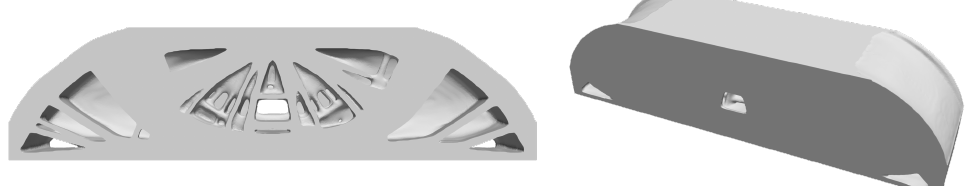
Figure 16. Derived design proposal of the optimization method for optimization case 1: Sectional view ( left ) and overall view ( right ).